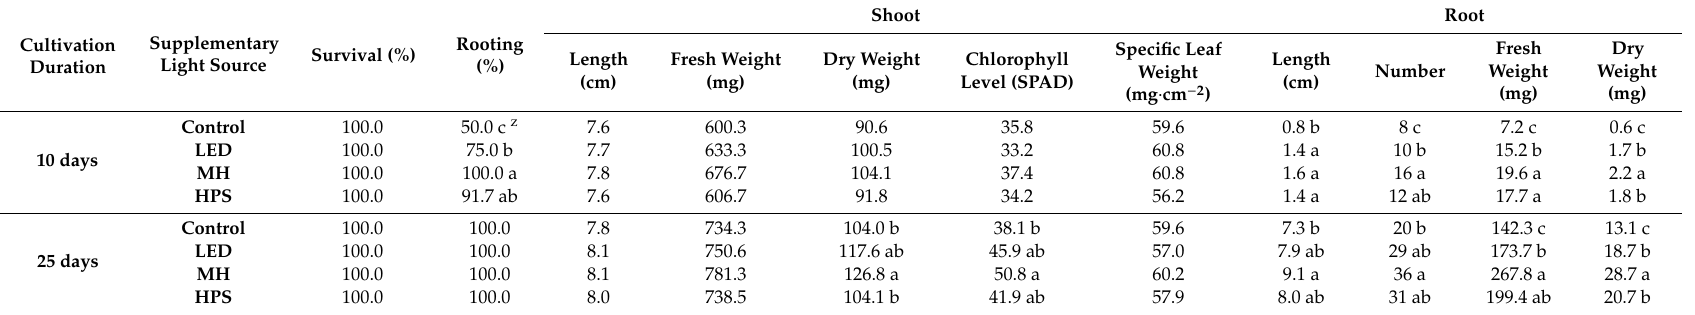
Table 2. The growth parameters, measured at 10 and 25 days after treatment initiation, of carnation ‘Dreambyul’ a ff ected by the supplementary light source.